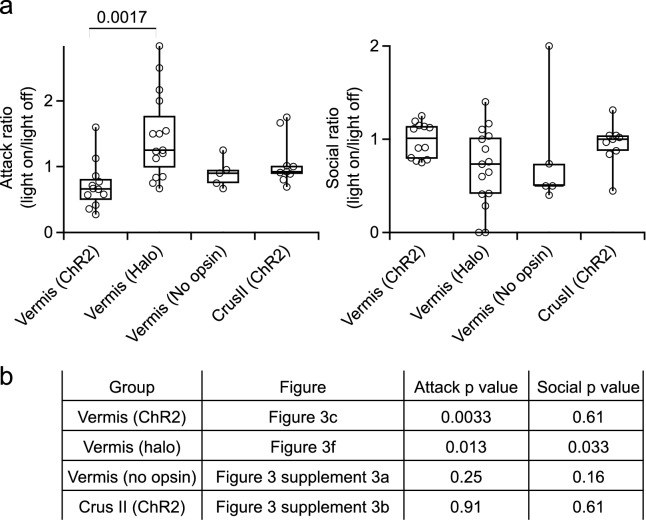
Statistical significance of behavioral effects.(a) Comparison of light-induced behavioral changes between experimental groups, for attack rates (left) and social investigations (right). Pairwise comparisons that were not significant (p>0.05) have not been labeled. (b) P values for light on/light off differences within experimental groups for rates of attack and social interactions. Data was first assessed for normality (Shapiro-Wilk test). Significance was assessed using two-tailed Student’s t-tests for data that met the criteria of normality, or Wilcoxon-Mann-Whitney tests for data that did not (see Materials and methods for details).